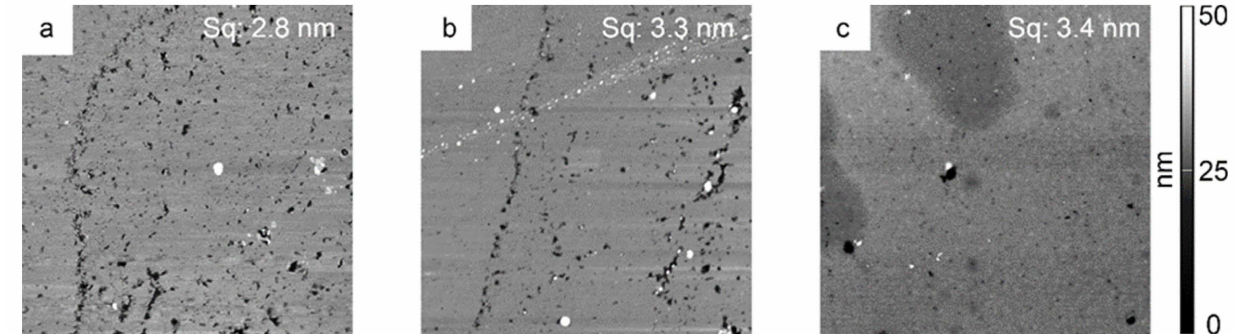
Figure 1. AFM images of polystyrene before and after oxygen plasma treatment and after acrylic acid grafting. The edge length of all AFM images is 10 µ m. ( a ) Polystyrene surface after hot pressing between two silicon wafers, before plasma activation, surface roughness Sq = 2.8 nm. ( b ) Polystyrene surface after plasma activation, Sq = 3.3 nm. ( c ) Polystyrene surface after plasma treatment and additional grafting with acrylic acid, Sq = 3.4 nm. The peaks were cut in the images to allow a better comparison of